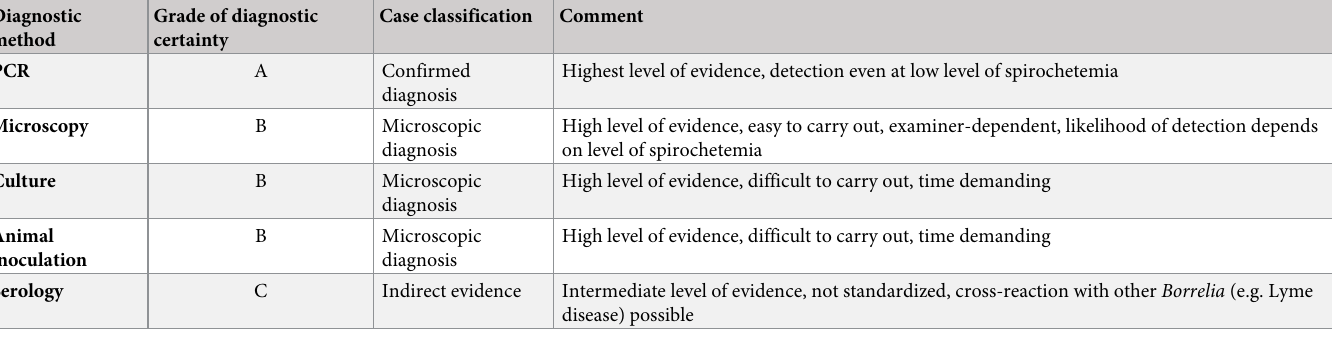
Table 2. Diagnostic grading system to judge the certainty of the correct diagnosis of